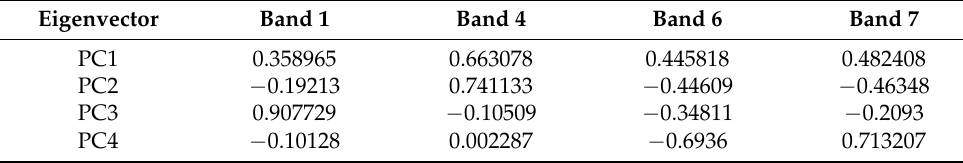
Figure 11. ( A ) PC2 image from PC analysis of bands 1467; ( B ) negated PC3 image from PC analysis of bands 1, 3, 5, and 6; ( C ) PC2 image from PC analysis of bands 1, 3, 5, and 8; ( D ) PC false-color composite image of negated PC4, negated PC3, and PC2 image. Table 10. Eigenvector loading for PC bands 1, 4, 6, and